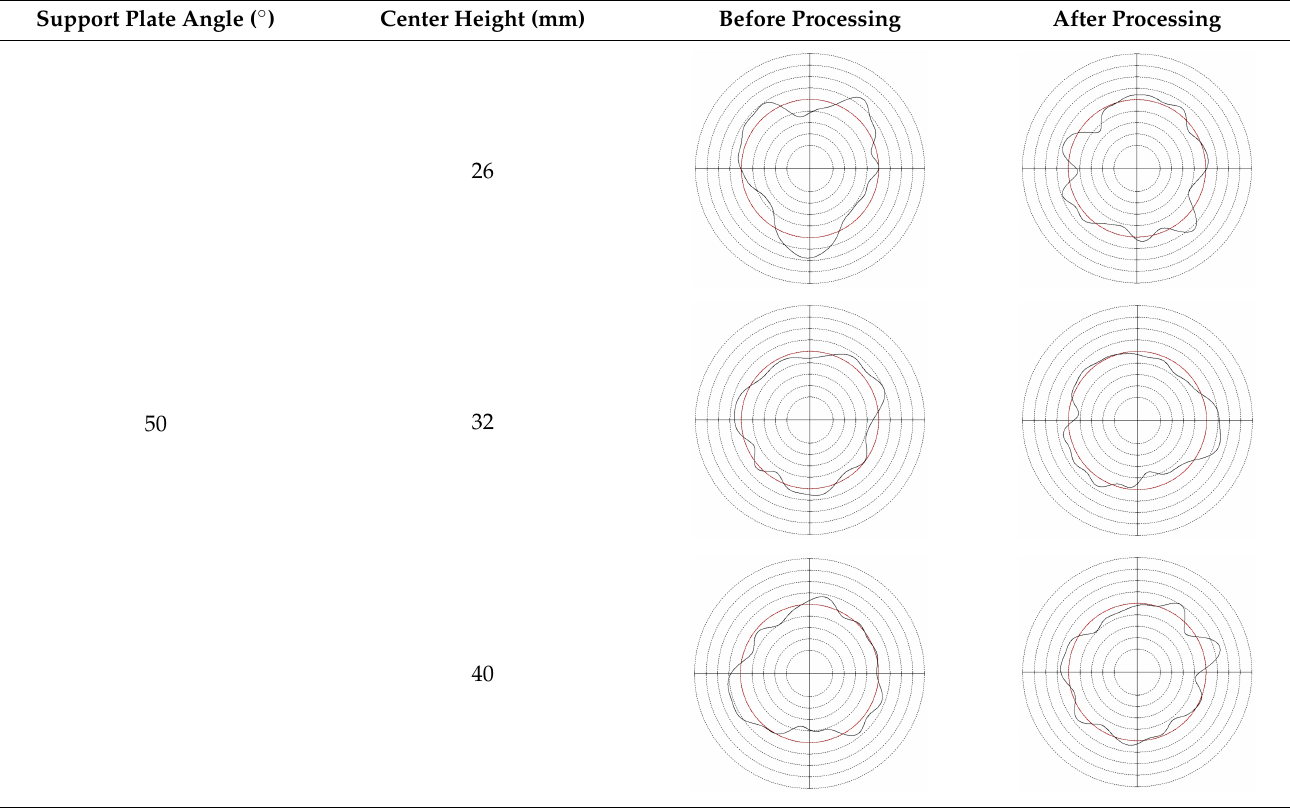
Figure 4. Influence mechanism of center height on profile shape: ( a ) the center height is negative, and the center of the workpiece is lower than the center line of the grinding wheel and the regulating wheel; ( b ) the center height is positive, and the center of the workpiece is higher than the center line of the grinding wheel and the regulating wheel.